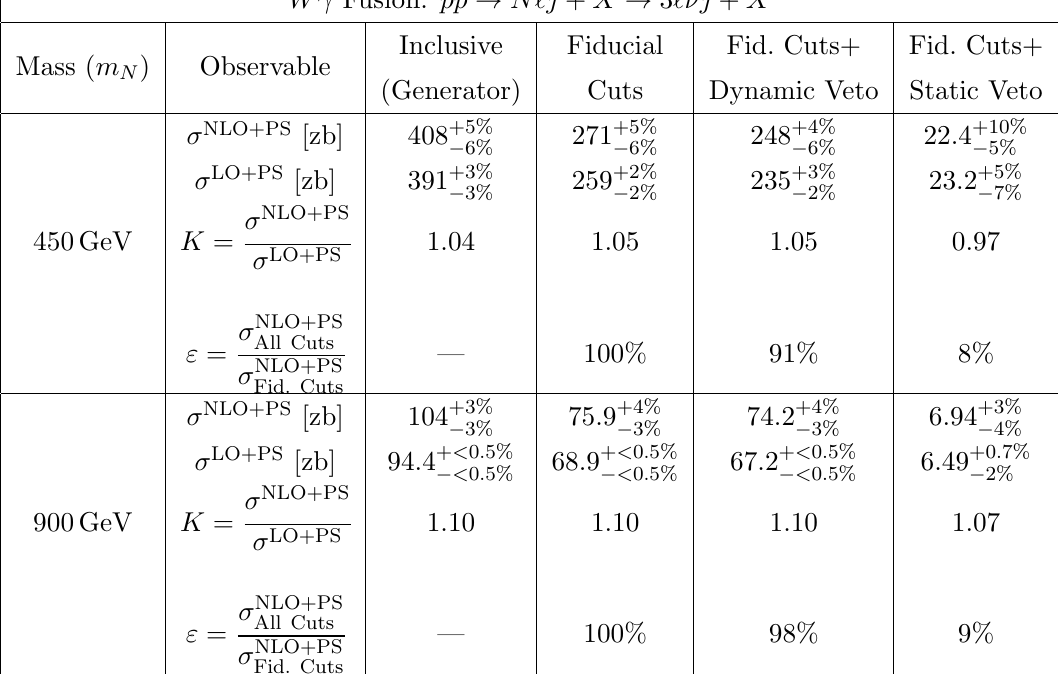
Table 3. Same as table 2 but for the VBF pp